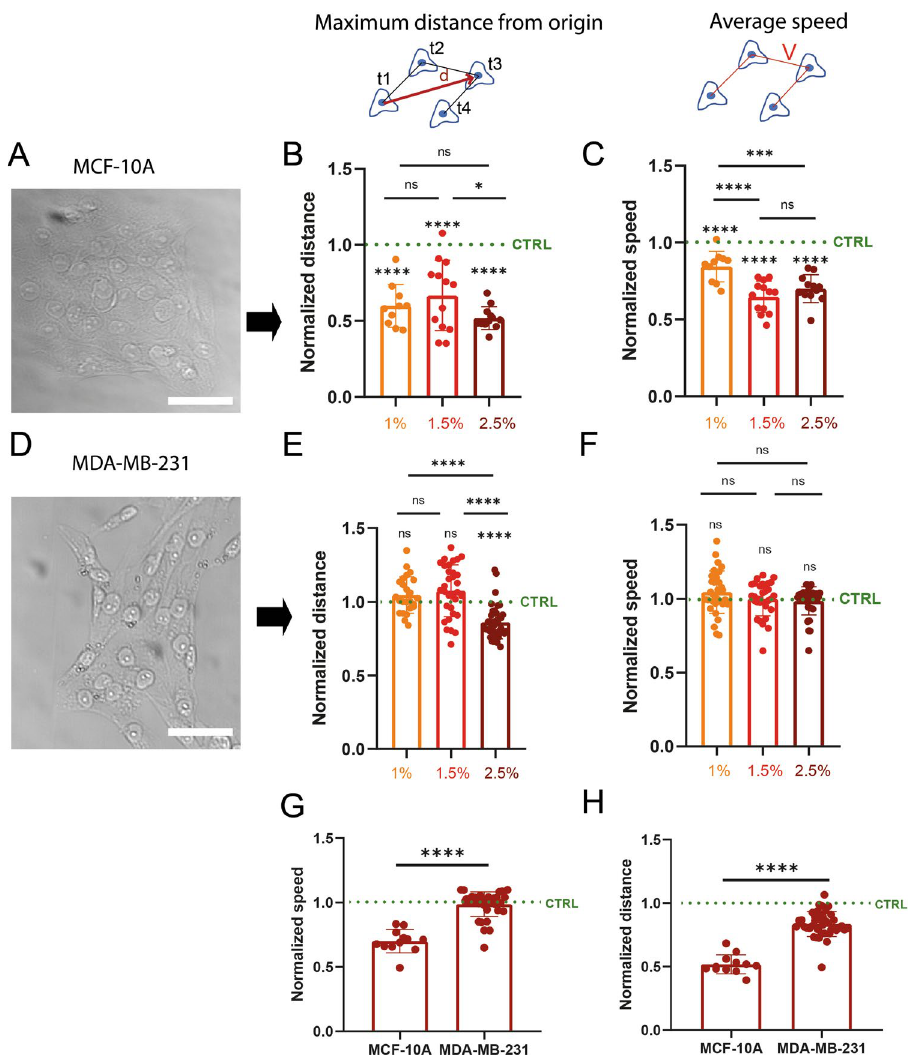
Figure 1. Osmotic-stress modulates migration and speed of non-tumorigenic epithelial cells, but not those of tumorigenic breast mesenchymal cells. Brightfield images of ( A ) MCF-10A and ( D ) MDA-MB-231 cell clusters. Scale bars correspond to 50 µm. Normalized maximum migration distances of ( B ) MCF-10A and ( E ) MDA-MB-231 treated with 1% (yellow), 1.5% (red) and 2.5% (dark red) PEG concentrations. For each cell type and PEG concentration, maximal distances of migration are normalized by maximum distance of migration of control cells. Normalized migration speeds of ( C ) MCF10A and ( F ) MDA-MB-231 treated with 1% (yellow), 1.5% (red) and 2.5% (dark red) PEG concentrations. For each cell type and PEG concentration, migration speeds are normalized by migration speeds of control cells. ( G ) Normalized migration speeds and ( H ) normalized migration distances for MCF-10A and MDA-MB-231 treated with 2.5% PEG. 10 ≤ n ≤ 13 independent experiments for MCF10A and 24 ≤ n ≤ 40 for MDA-MB-231. *0.01 < p < 0.05, **0.001 < p < 0.01, ***0.0001 < p < 0.001, **** p < 0.0001 and n.s.